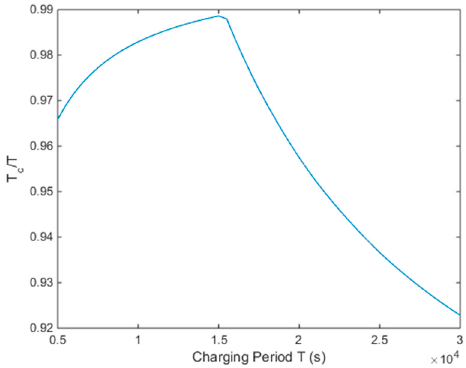
Figure 5. The trend of T c / T changes with T.